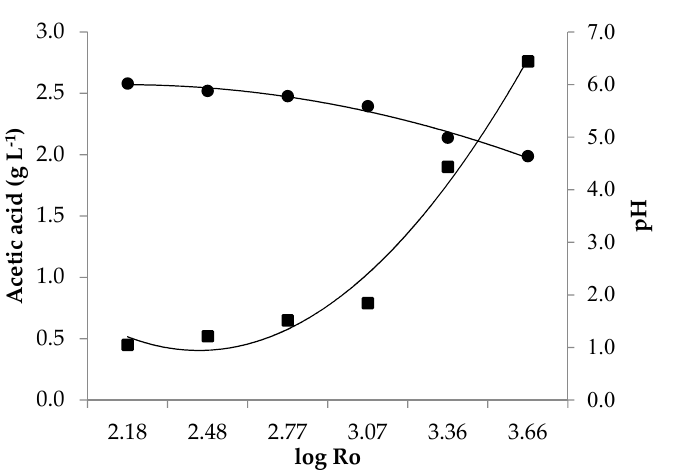
n.d. not detected. Double determination. Coefficient of variation was under 3% for all parameters. Residual RD calculated in % from solid fraction of RD pretreated. Acetic and propionic acids were the only volatile acids found. Acetic acid was pro- duced up to 11 times more than propionic acid. The presence of acetic acid was raised by increasing the pretreatment severity, with a marked increase when log Ro > 3.07 (Figure 2). Its formation as a function of log Ro fitted well (R 2 = 0.98) with a quadratic model (Equation (7)). For log Ro ≤ 3.07, corresponding to temperatures of 140 and 160 °C, the acetic acid concentration went from 0.45 to 0.79 g L − 1 (Figure 2). A maximum value of 2.76 g L − 1 was determined for log Ro = 3.66 (180 °C for 20 min).